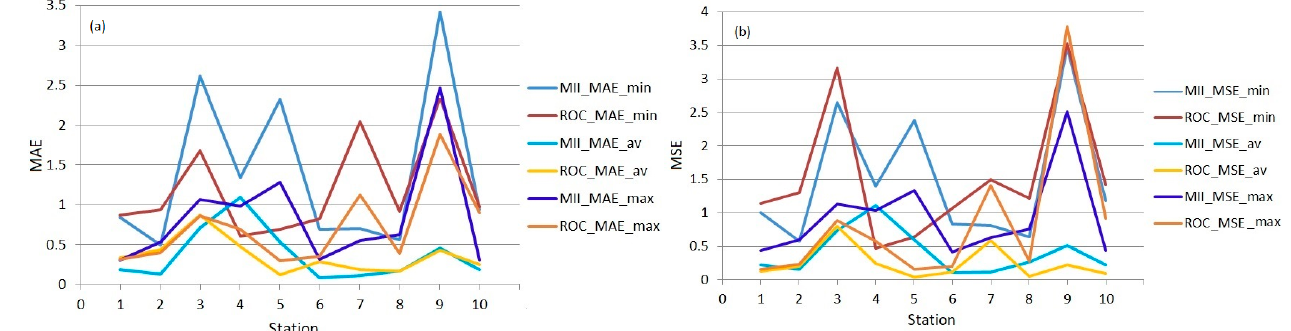
Figure 13. Comparisons between ( a ) MAEs and ( b ) MSEs from the models.